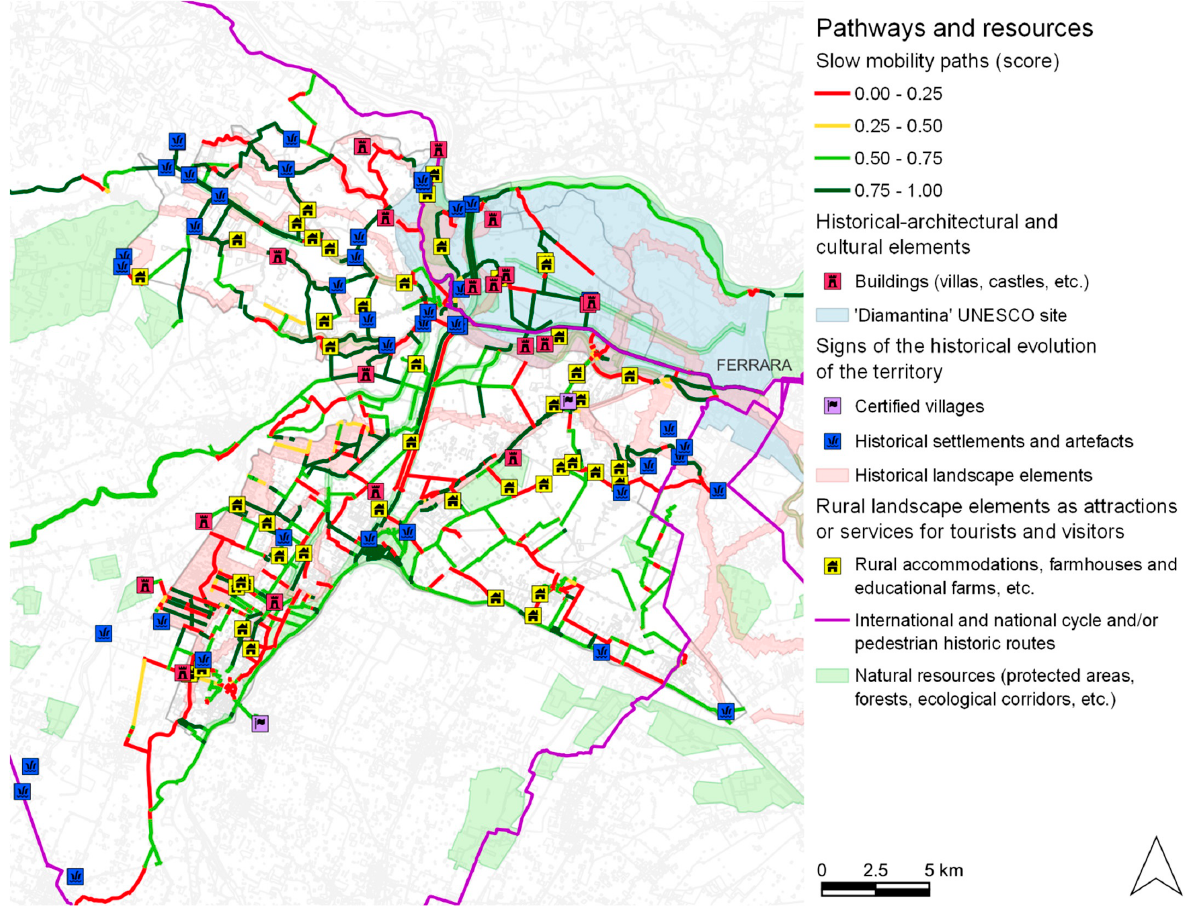
Figure 7. NPV of existing paths and landscape resources.